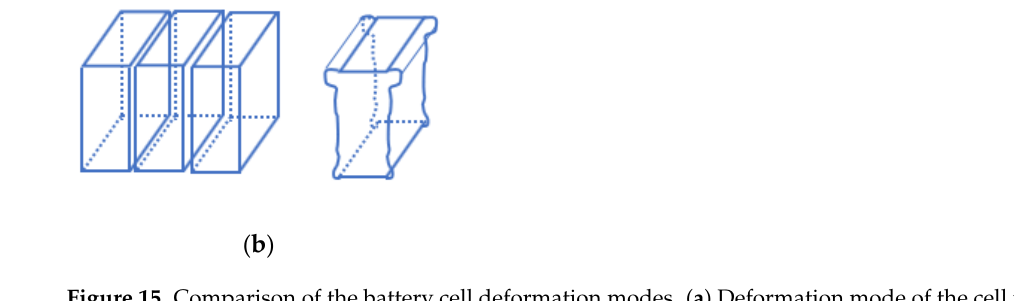
Figure 15. Comparison of the battery cell deformation modes. ( a ) Deformation mode of the cell in a free state; ( b ) Deformation mode of the cell under module constraint.